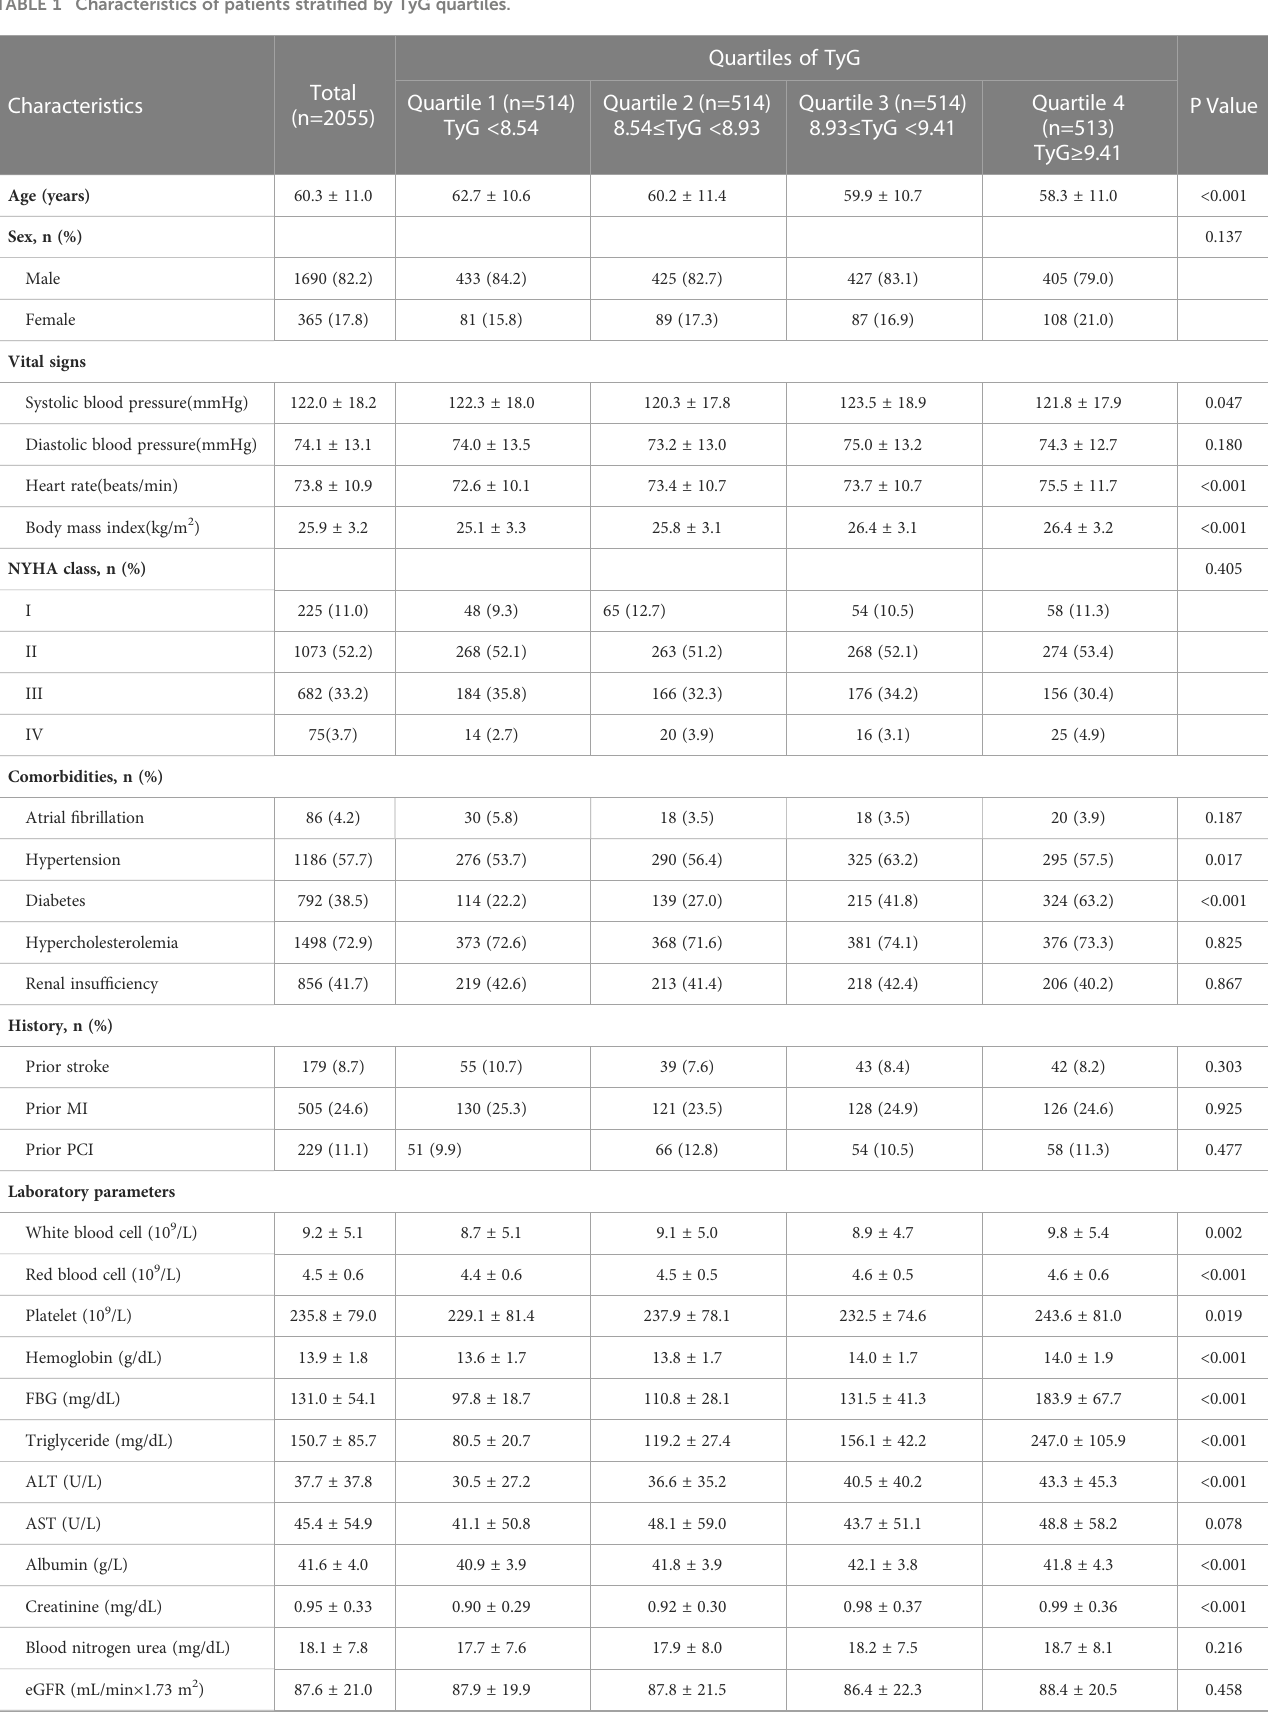
TABLE 1 Characteristics of patients strati fi ed by TyG quartiles.